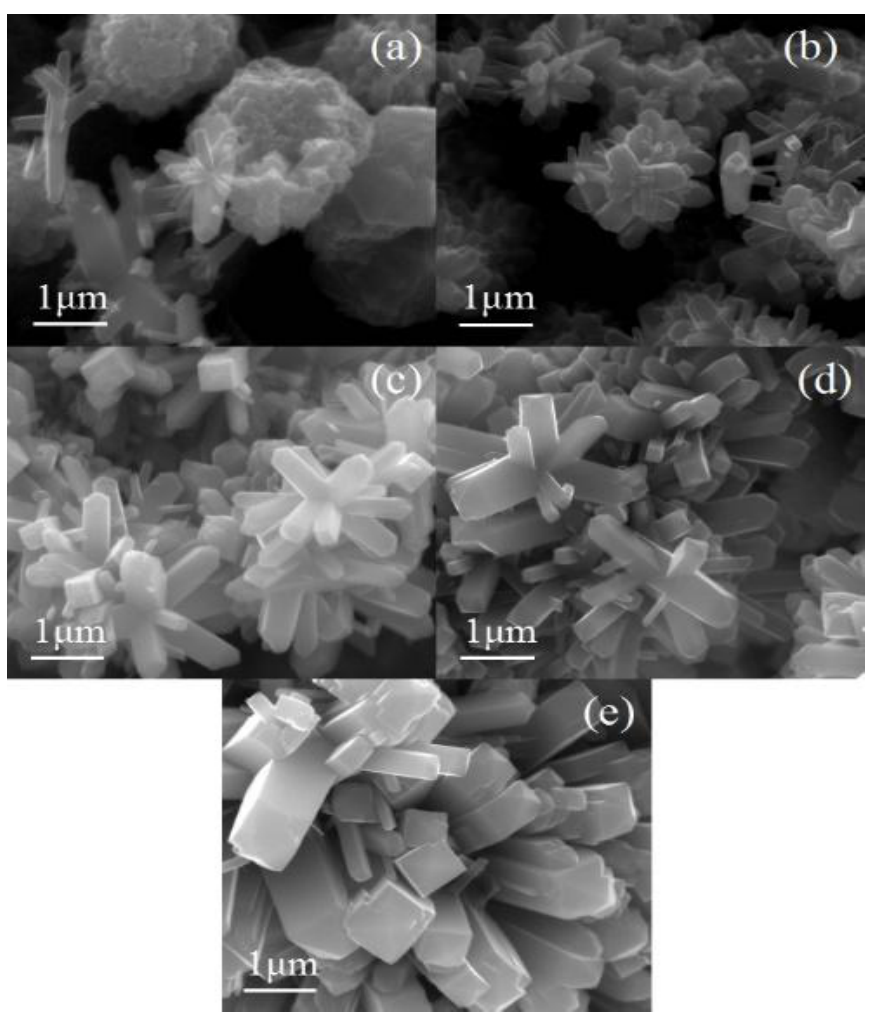
Figure 9. SEM images wtih different time. ( a ) 8 h; ( b ) 10 h; ( c ) 12 h; ( d ) 14 h; ( e ) 16 h.